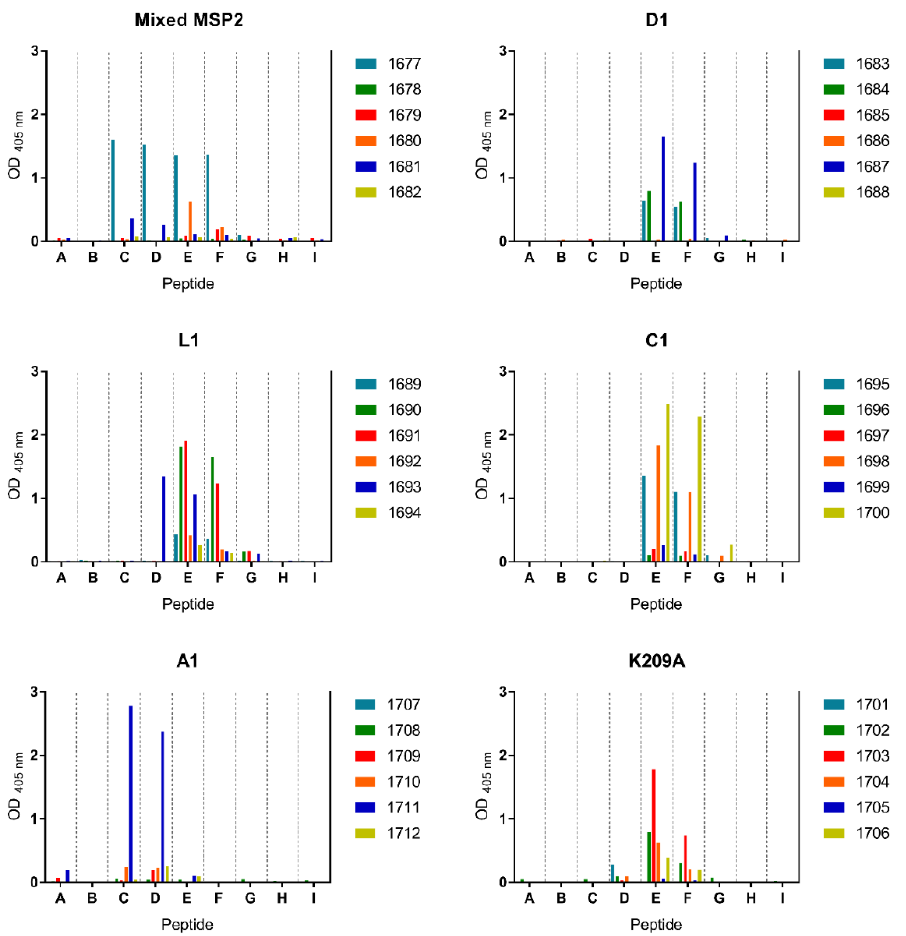
Figure 5. Antibody specificities of individual mice from each group were determined by peptide array (peptides A–I), numbers 1677–1712 indicate individual mice. Table 3. Peptide array used to probe antibody specificities, peptides C-D encompass the 9H4